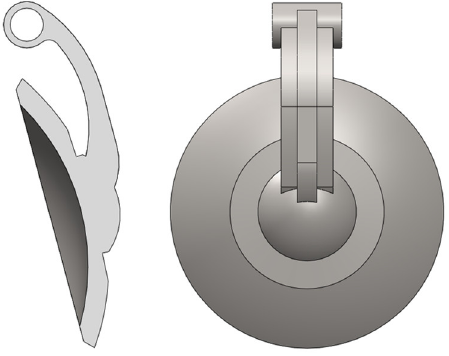
Figure 17. Optimized valve disc model.